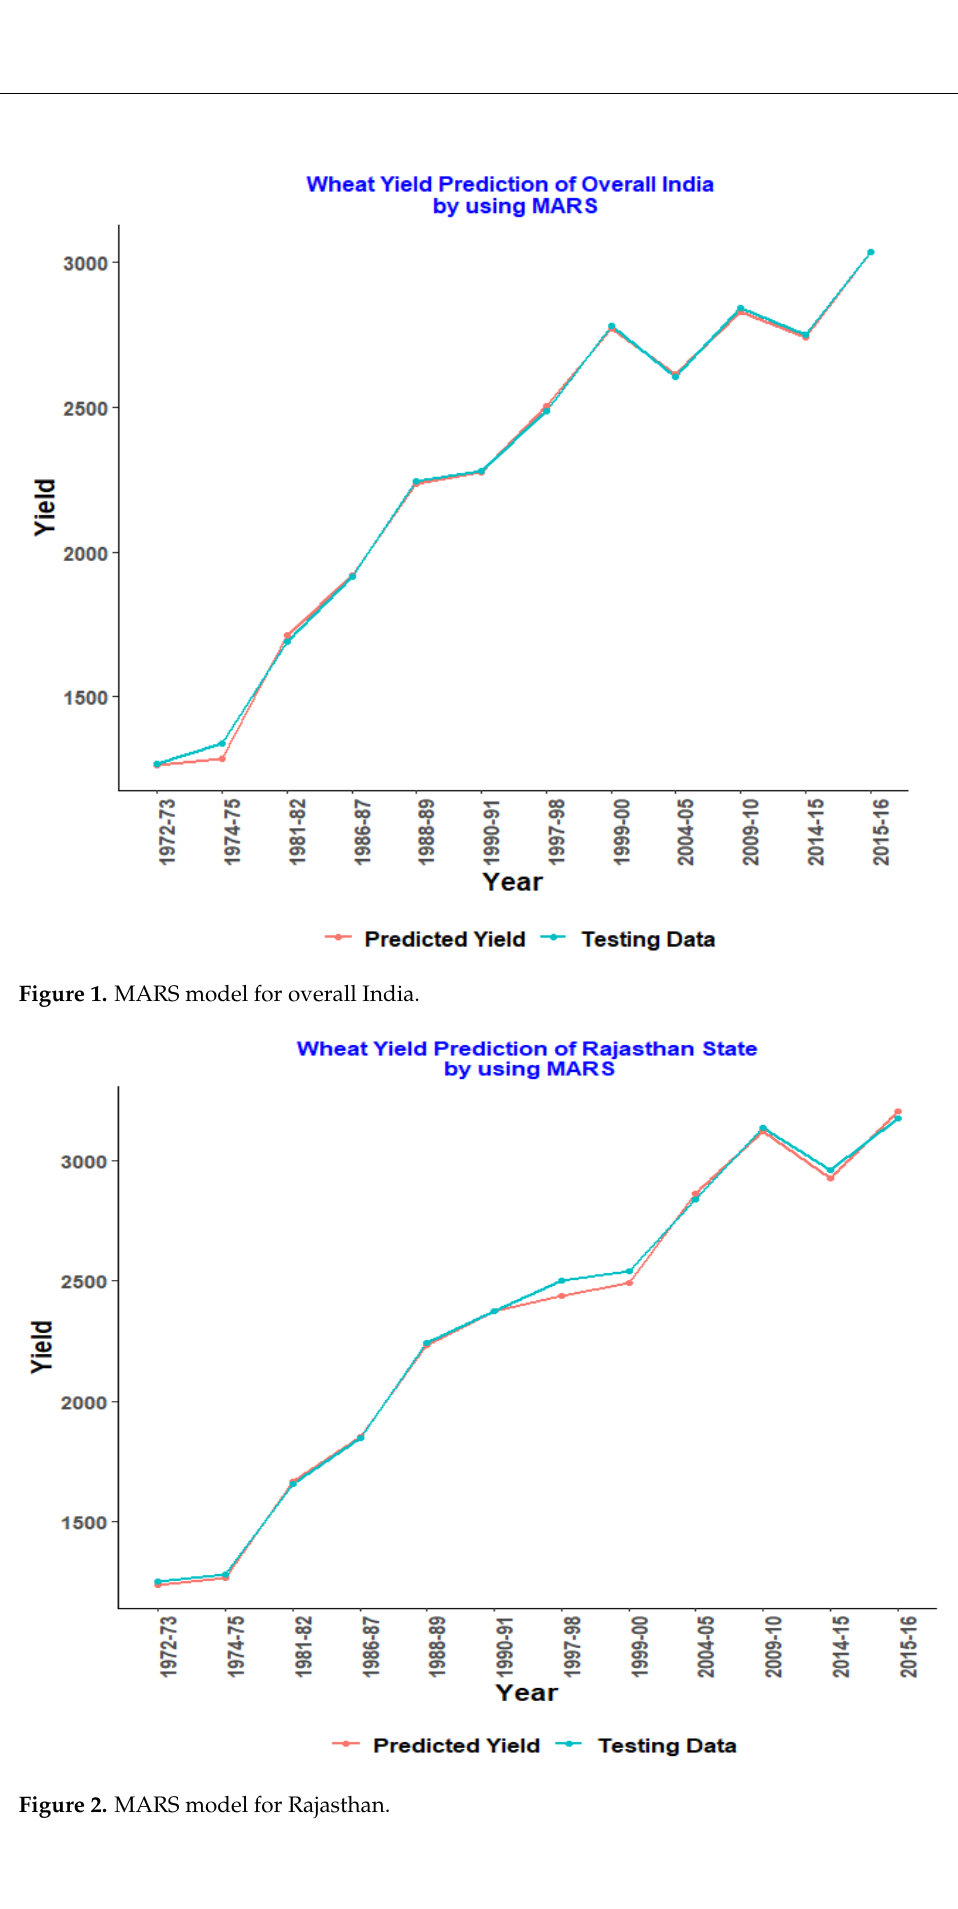
Figure 2. MARS model for Rajasthan.